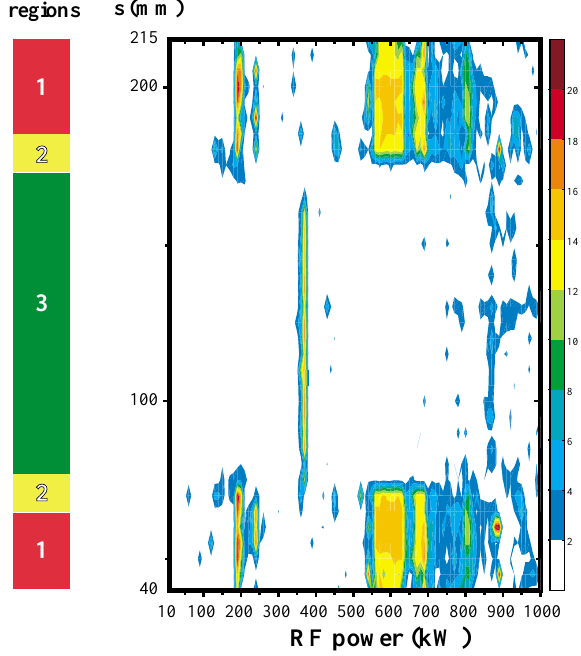
FIG. 7. (Color) Simulated log (cid:1) N e (cid:2) as a function of rf input power and electron starting position s for the iris-type TW